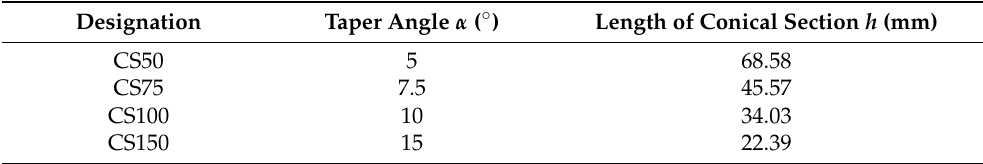
Table 1. Geometric parameters of CS dies.